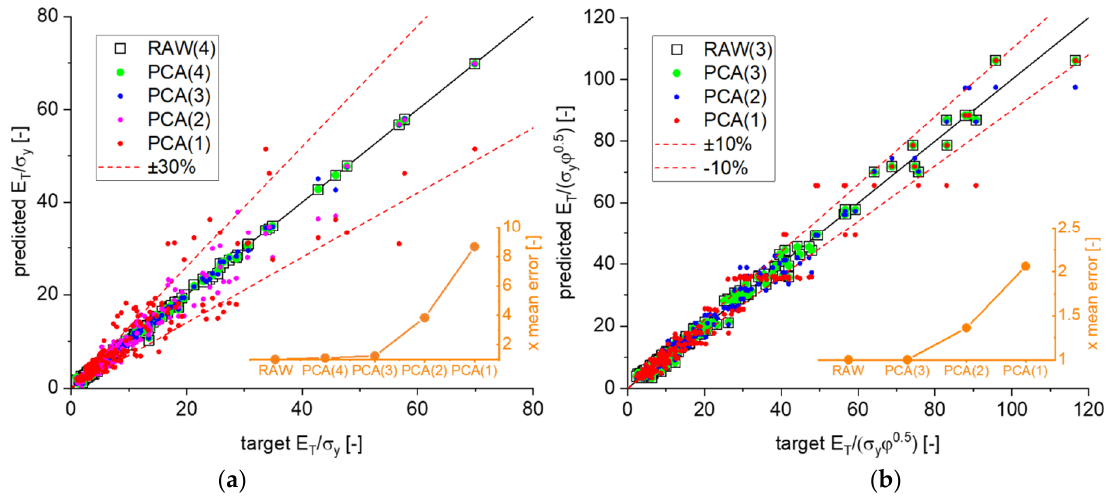
Figure 6. Quality of MLP regression after PCA with decreasing number of components. ( a ) (cid:1831) (cid:3021) /(cid:2026) (cid:3052) , Equation (16) with ≤ 4 components and ( b ) (cid:1831) (cid:3021) /((cid:2026) (cid:3052) (cid:2030) (cid:2869)/(cid:2870) ) scaled according to Equation (18) with ≤ 3 components.